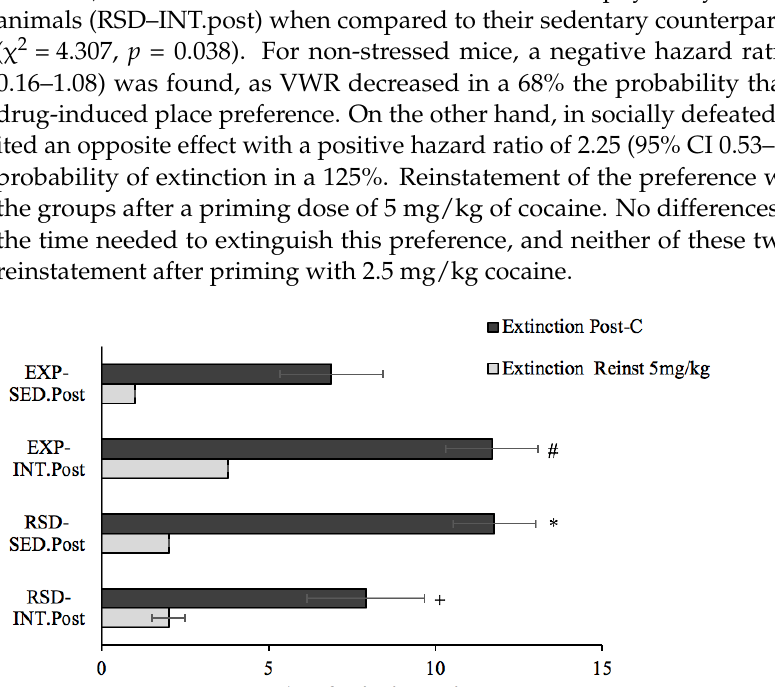
Figure 9. An increase of physical exercise during the extinction of drug-associated memories modifies the number of sessions needed to extinguish CPP induced by 10 mg/kg of cocaine. Black bars represent the mean of sessions required to extinguish the preference induced by 10 mg/kg cocaine, while gray bars represent the sessions required to extinguish the reinstated preference with a priming dose of 5 mg/kg cocaine; * p < 0.05 significant difference with respect EXP–SED.post group; # p < 0.05 significant difference with respect EXP–SED.post; + p < 0.05 significant difference with respect